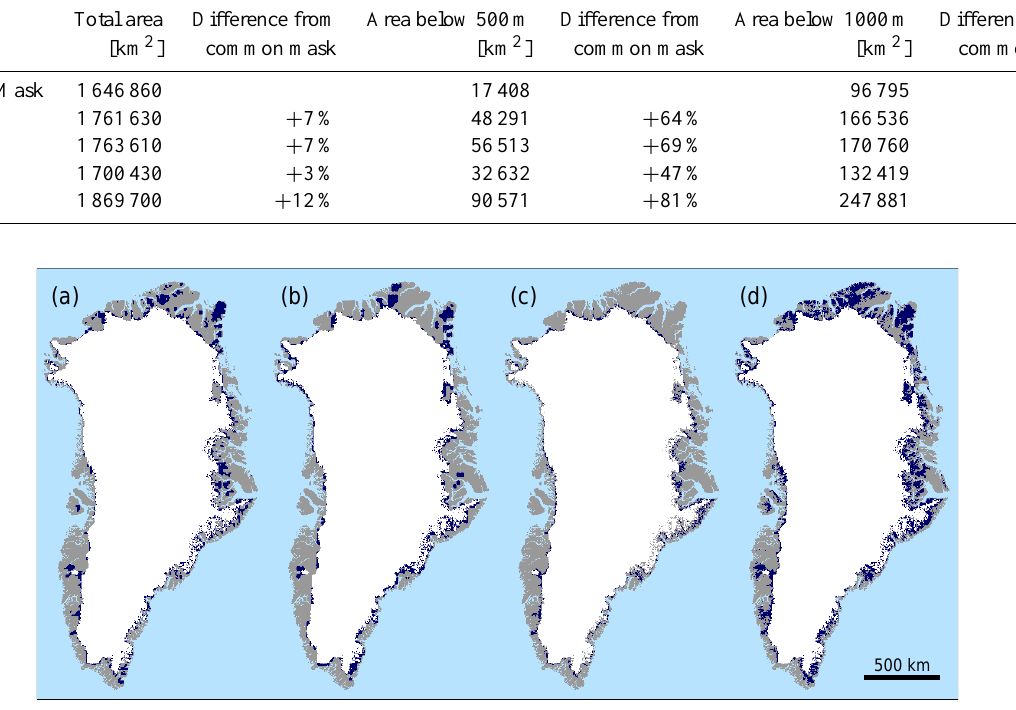
Fig. 1. Four ice sheet masks. Areas in white are common to all masks, dark blue represents additional areas of each mask (a) RACMO, (b) MAR, (c) ECMWFd, (d) PMM5. Land area is shown in